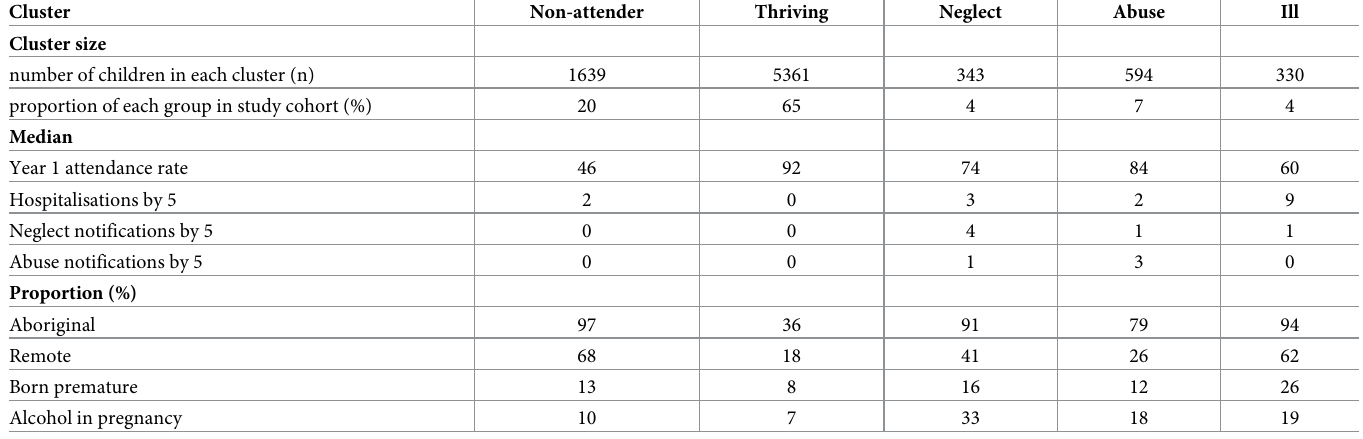
Table 3. Post-hoc cluster analysis of Model